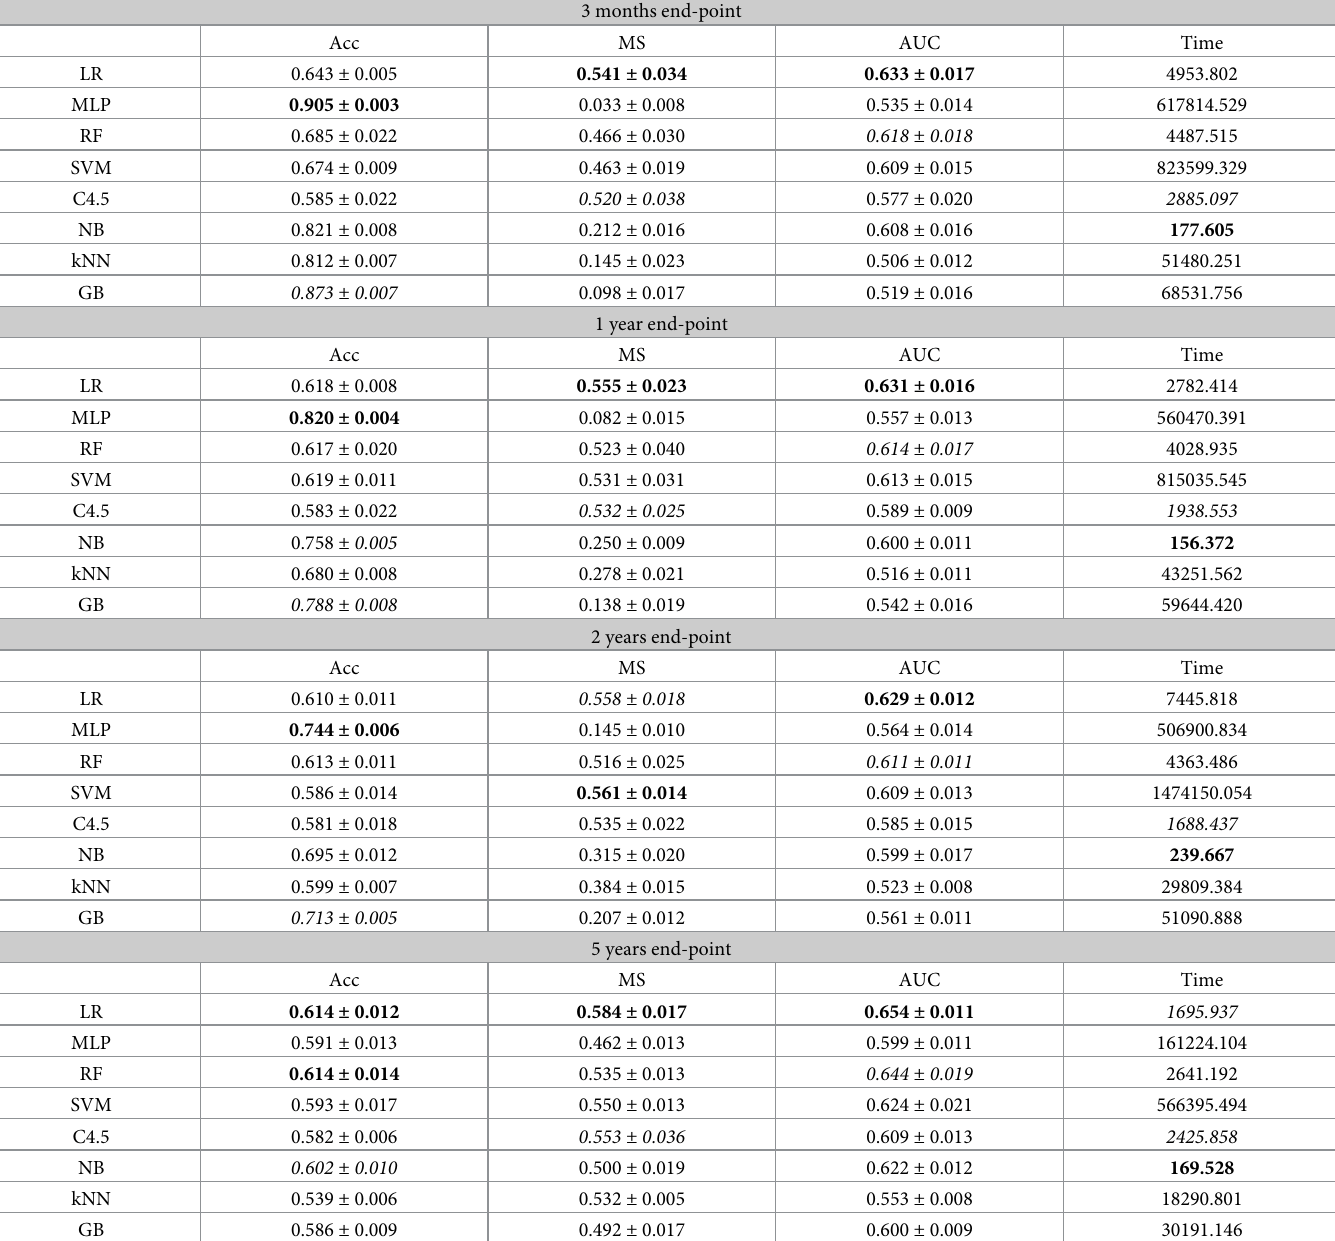
Table 4. Mean ± SD of the Acc, MS and AUC evaluation metrics (values between 0 and 1). The time (measured in seconds) is the total time needed for completing the external